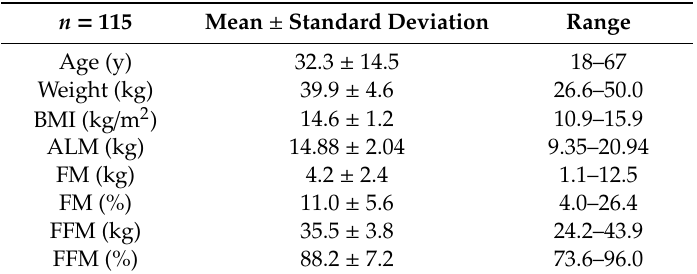
Table 3. Demographic data of patients.